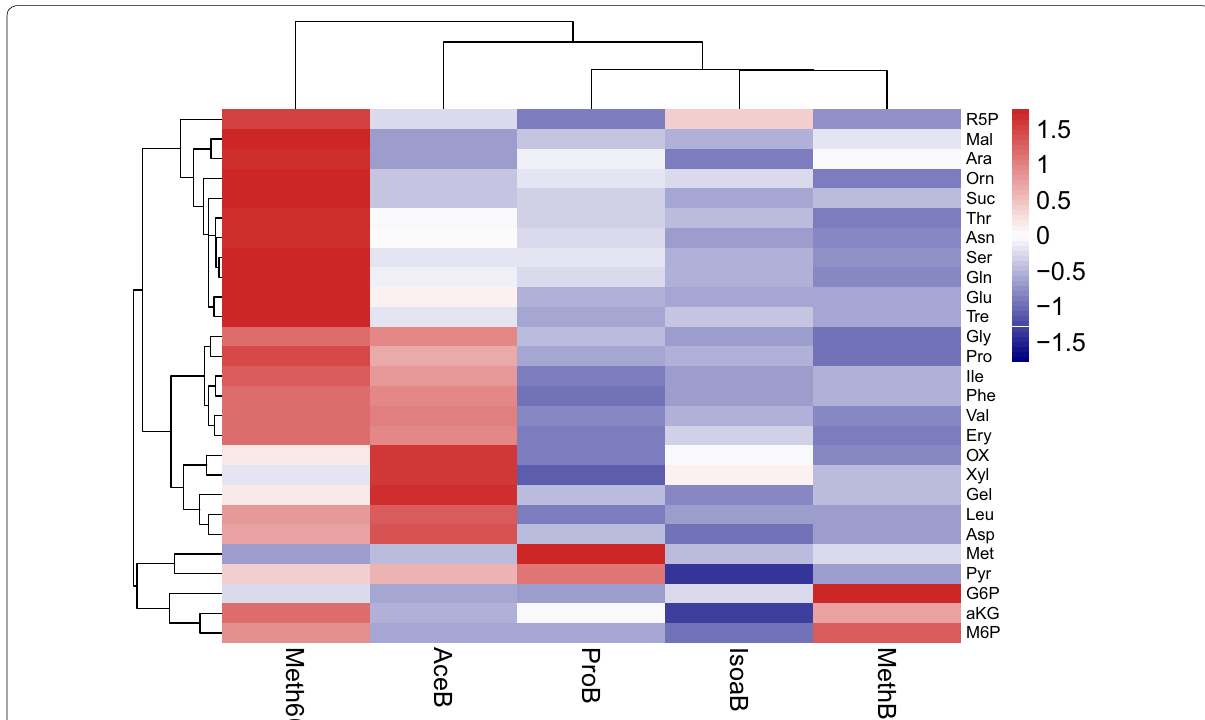
Fig. 3 Hierarchical clustering analysis of the metabolites from the QS fraction. The concentration (μmol gDCW − 1 ) of metabolites from the QS fraction was used for clustering analysis. The QS was the quenching supernatant of the centrifugal samples. The QS were attained from Meth60: 60% methanol; AceB: acetone; ProB: propanol; IsoaB: isoamylol; and MethB: methanol with base solution 5:1 (v/v) at 30 °C, respectively. Base − solution was made up of acetone: ethanol 1:1 (mol/mol). Clustering scaled and distance measure utilized in clustering rows by Euclidean distance. = Each row and column indicated an individual metabolite and QS, respectively. R5P ribose-5-phosphate, Mal malate, Ara arabitol, Orn ornithine, Suc succinate, Thr threonine, Asn asparaginate, Ser serine, Gln glutamine, Glu glutamate, Tre trehalose, Gly glycine, Pro proline, Ile isoleucine; Phe phenylalanine, Val valine, Ery erythritol, OX oxalic acid, Xyl xylitol, Gel glycerol, Leu leucine, Asp aspartate, Met methionine, Pyr pyruvate, G6P glucose-6-phosphate, aKG alpha-ketoglutarate, M6P